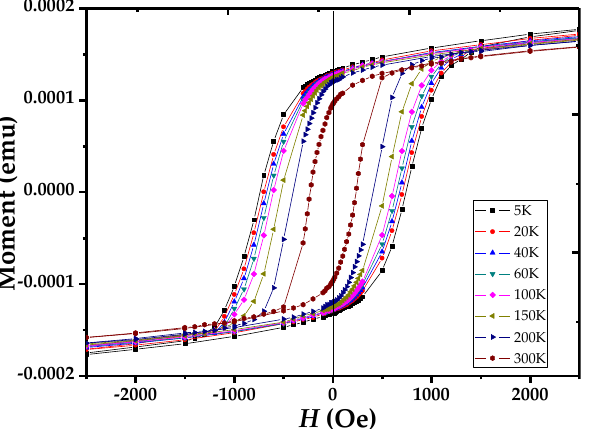
Figure 4. Hysteresis loops of Ni nanotubes taken at 5, 20, 40, 60, 100, 150, 200, and 300 K with the field applied parallel to the tube’s axis.